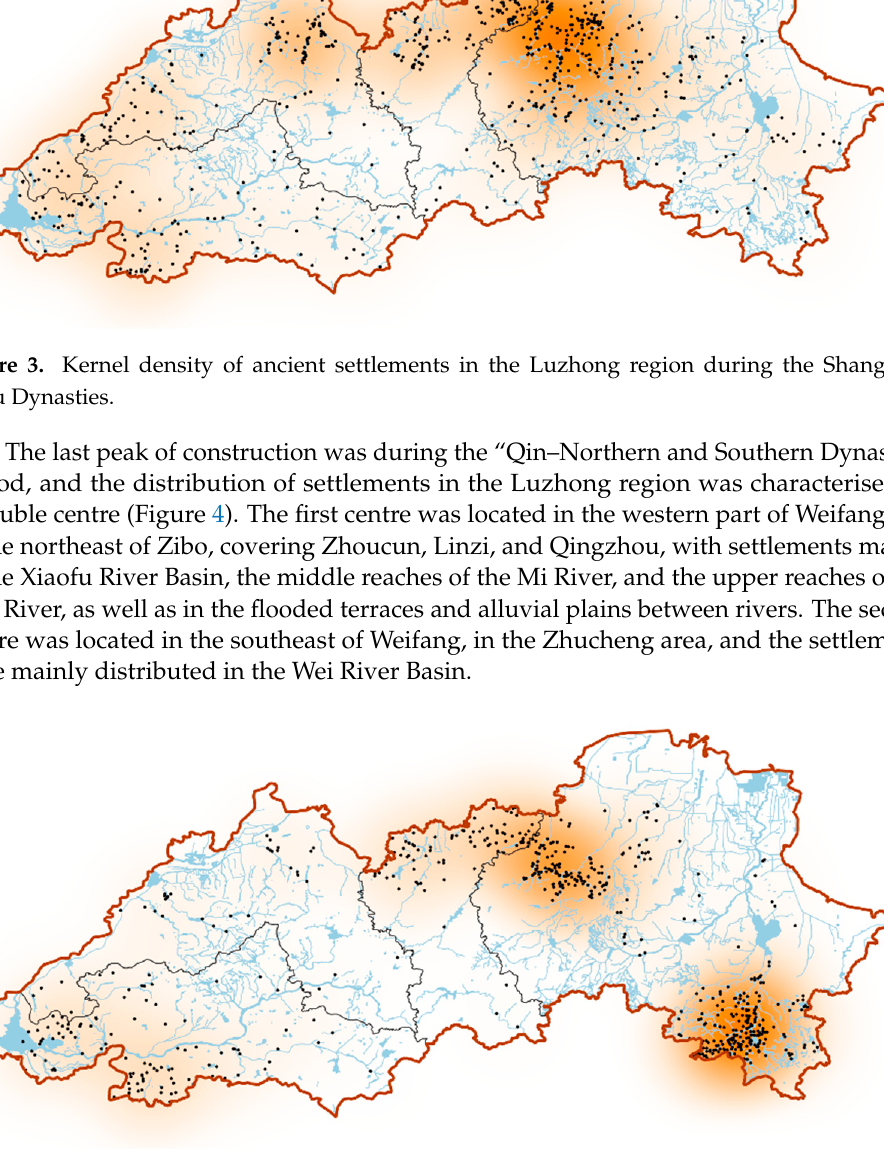
Figure 4. Kernel density of ancient settlements in the Luzhong region during the “Qin – Northern and Southern Dynasties” period.